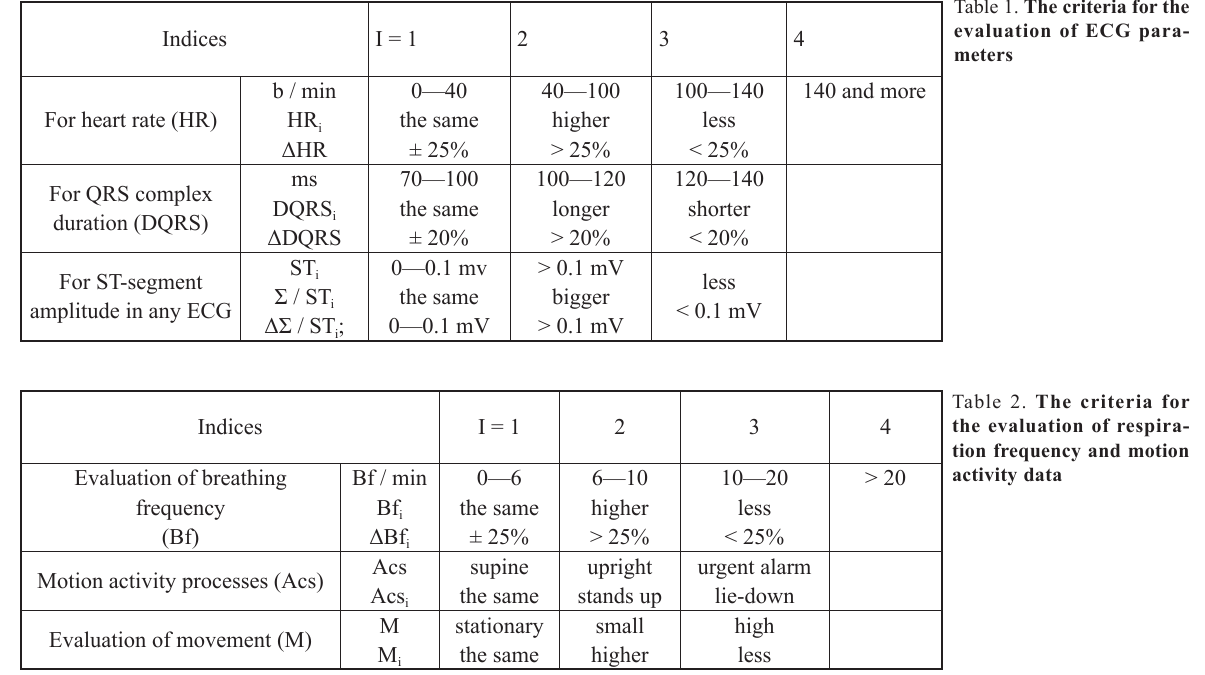
Table 1. The criteria for the evaluation of ECG para-